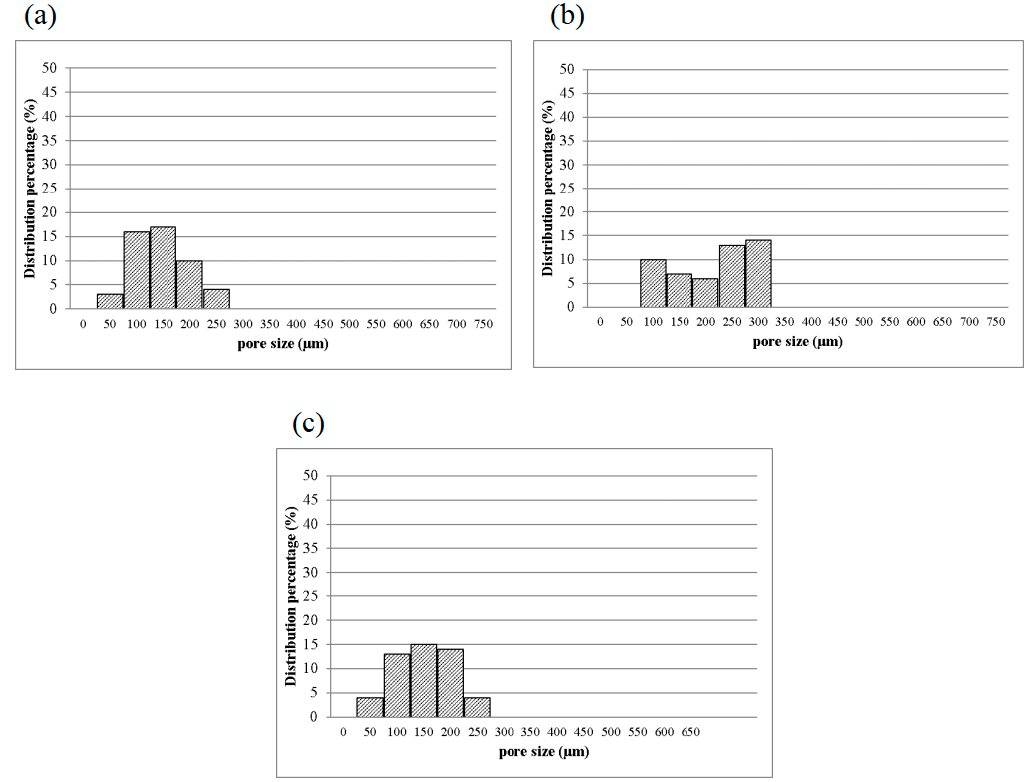
Figure 7. Pore diameter distribution of CS/Gel/MMT/PCL bone scaffolds of ( a ) 1MCG-P, ( b ) 2MCG-P, and ( c ) 5MCG-P.